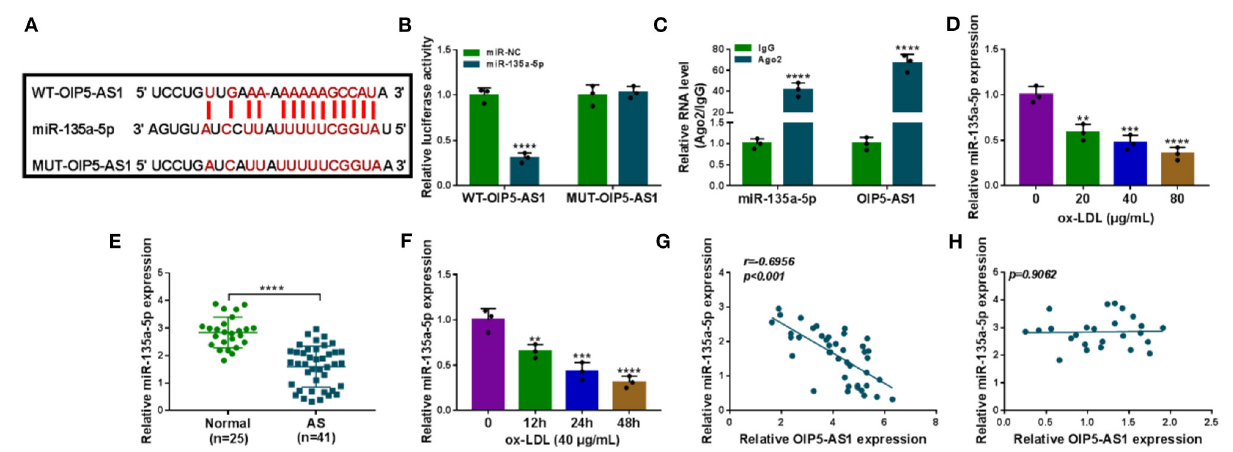
FIGURE 3 | OIP5-AS1 acted as a miR-135a-5p sponge. (A) Schematic model of the miR-135a-5p-binding sites within OIP5-AS1 identified by starBase v.2 software and mutated miR-135a-5p-binding sites. (B) Relative luciferase activity in HUVECs cotransfected with WT-OIP5-AS1 or MUT-OIP5-AS1 and miR-135a-5p mimic or miR-NC mimic. n = 3 independent biological replicates; error bars represented SD; **** P < 0.0001 by Student’s t -test. (C) The levels of miR-135a-5p and OIP5-AS1 by qRT-PCR in cell lysates incubated with anti-Ago2 or anti-IgG antibody. n = 3 independent biological replicates; error bars represented SD; **** P < 0.0001 by Student’s t -test. MiR-135a-5p level by qRT-PCR in 41 atherosclerosis serum samples and 25 normal controls (D) , HUVECs after stimulation with 20, 40, and 80 µ g/ml of ox-LDL for 24h (E) , HUVECs after 40 µ g/ml of ox-LDL treatment for 12, 24, and 48h (F) . Error bars represented SD; ** P < 0.01, *** P < 0.001, or **** P < 0.0001 by Student’s t -test or one-way ANOVA with Tukey’s post hoc test. Correlation between miR-135a-5p expression and OIP5-AS1 level in AS serum samples (G) and control serum (H) using the Spearman